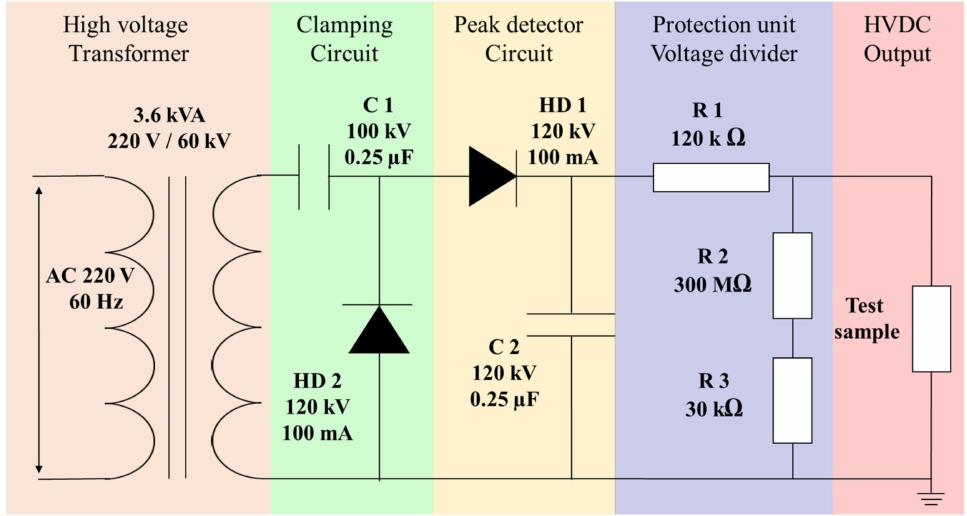
Figure 3. The circuit for breakdown voltage test.